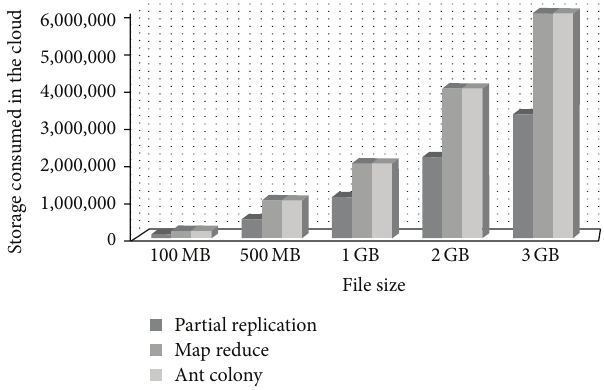
Figure 10: Storage consumption comparison using 2 cloud servers.